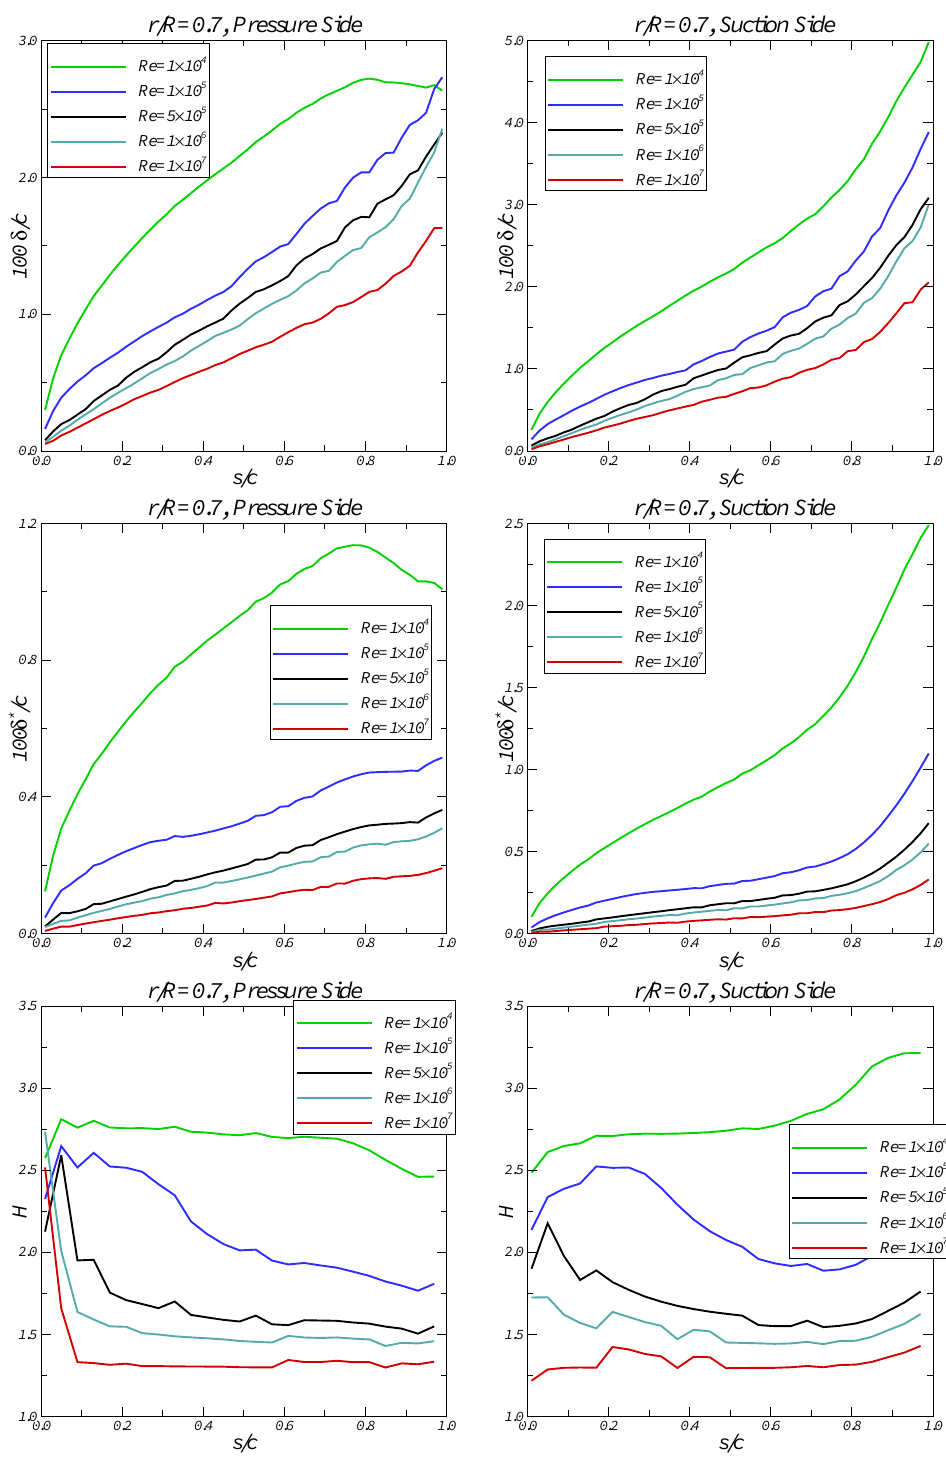
Figure 21. Boundary-layer thickness δ ( top ), displacement thickness δ ∗ ( middle ), and shape factor H ( bottom ) at r / R = 0.7 using the k − ω SST turbulence